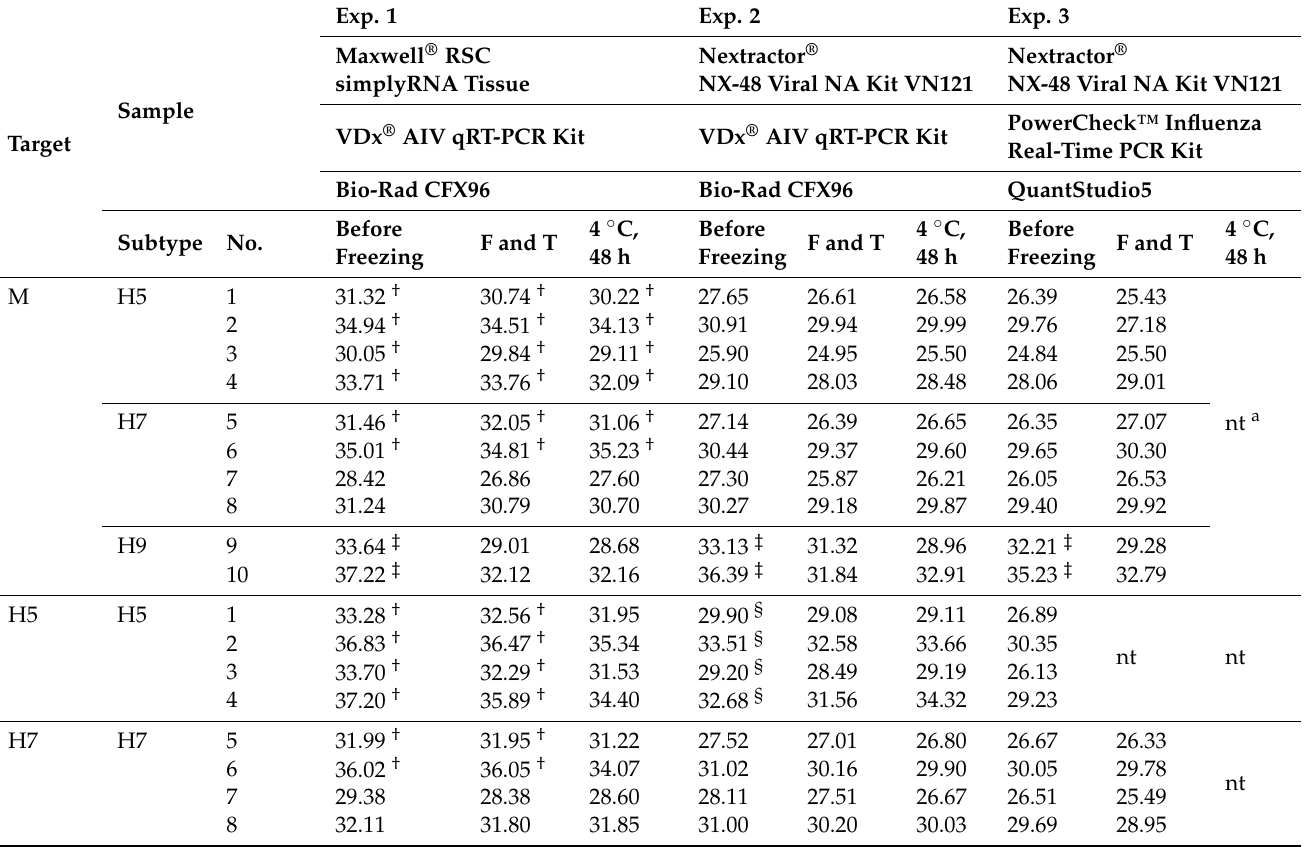
Table 2. M, H5, and H7 gene-specific real-time RT-PCR results for PT panel viruses in different experimental protocols in 2022 PT